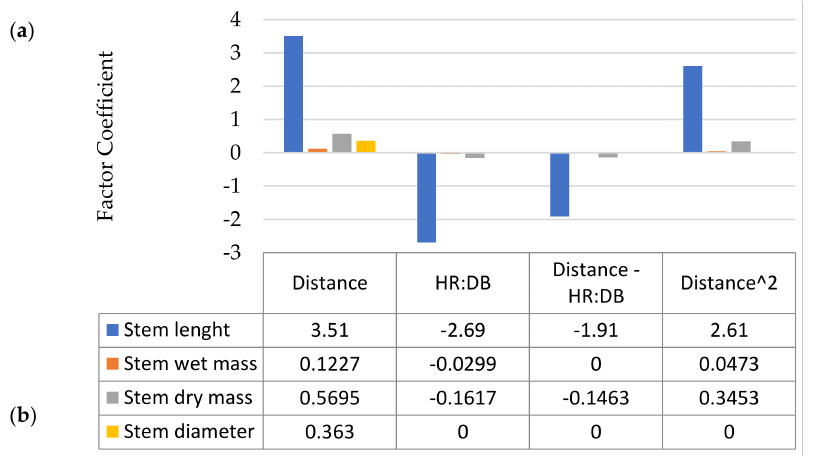
Figure 9. Effects sizes of the most relevant independent variable on several significant responses related to stem. ( a ) Graphical trend and ( b ) numerical coefficients (error bar = 0.05%, too small to be visible on the graph).